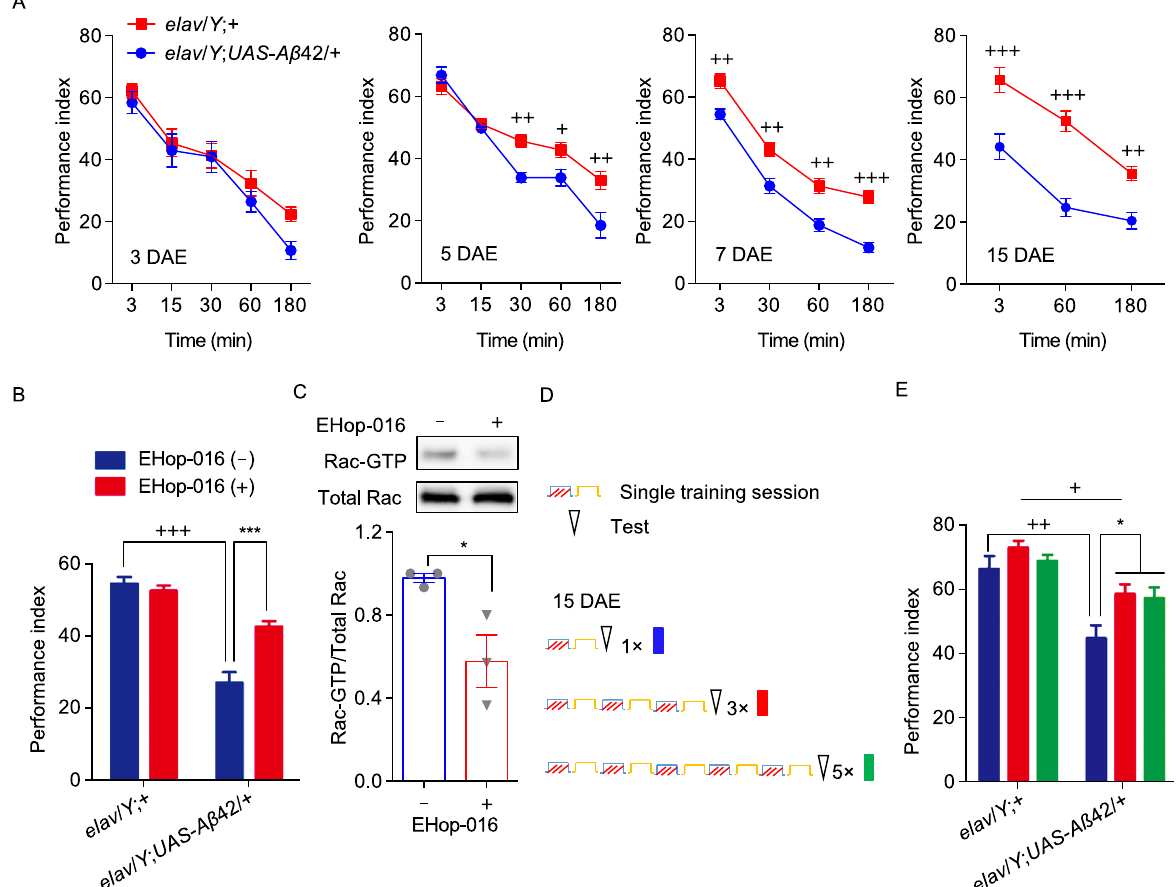
Figure 4. Rac1-dependent forgetting contributes to memory loss in an age-dependent manner in the Tg-AD fl y model. (A) Memory curves of AD fl ies at different ages (days after eclosion, DAE), (+ P < 0.05, ++ P < 0.01, +++ P < 0.0001, two-way ANOVA followed by Tukey ’ s multiple comparison test, 3 DAE: n = 6, 5 DAE: n = 12, 7 DAE: n = 6, 15 DAE: n = 10). (B) Administration of